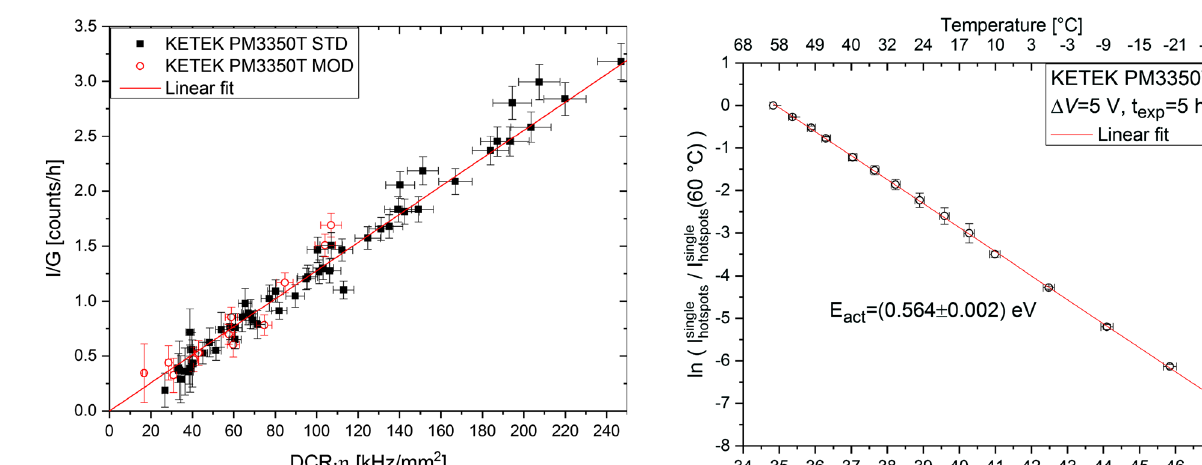
( T ) normalized to I single ( T = hotspots hotspots